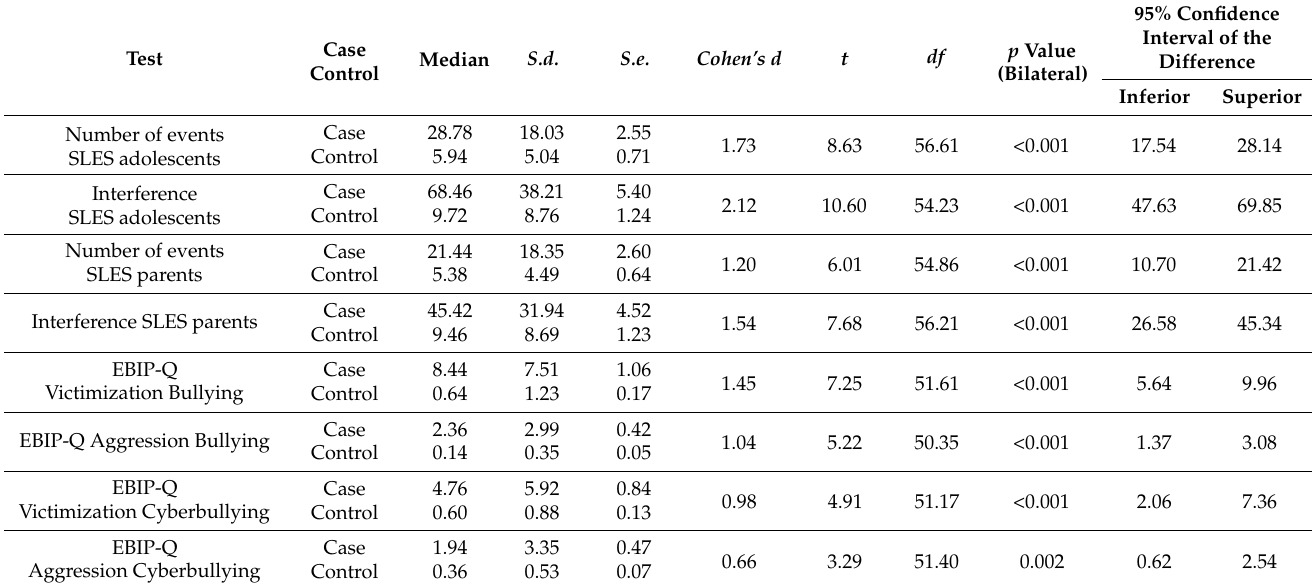
Table 3. Comparison of traumatic events (SLES, Bullying, and Cyberbullying) between cases and controls ( n cases = 50, n controls =